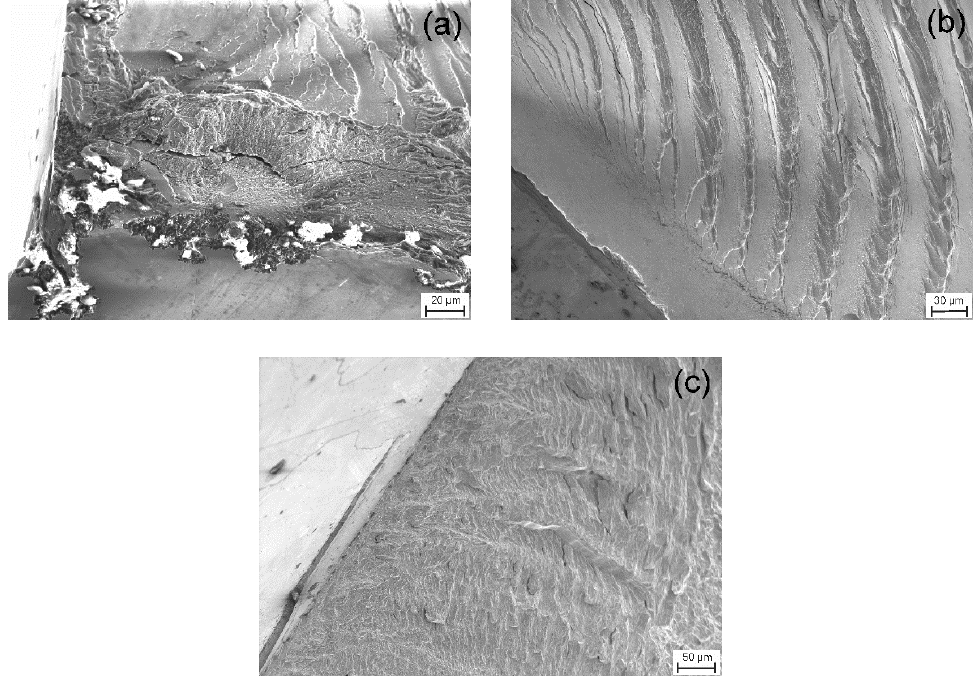
Figure 5. Fracture surface of a bulk glass forming Zr 52.5 Cu 17.9 Al 10 Ni 14.6 Ti 5 alloy (Vitreloy 105) sample fractured by stress corrosion cracking in 0.01 M Na 2 SO 4 + 0.01 M NaCl under three point bending and anodic polarization. ( a ) Crack initiation location; ( b ) Stable crack propagation region close to lateral side (perpendicular to tension side) of fractured bending sample; ( c ) Stable crack propagation region close to tension side of fractured bending